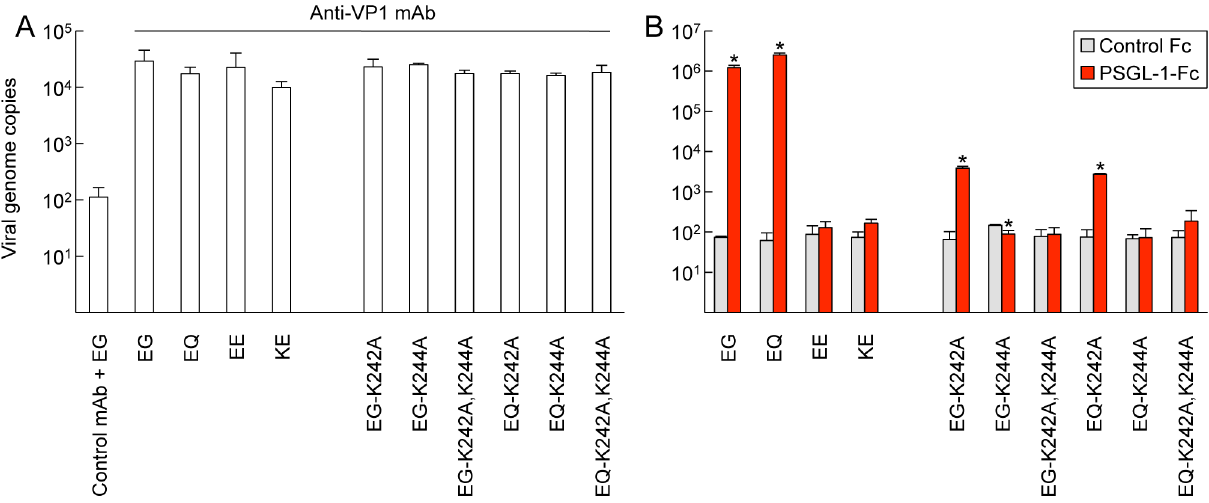
Figure 5. EV71–PSGL-1 binding assay using real-time RT-PCR. Viruses (5 6 10 7 viral genomes) were incubated with anti-VP1 mAb or PSGL-1-Fc and collected with protein G beads. Precipitated viruses were analyzed by real-time RT-PCR as described in Materials and Methods. Viral genome copies are expressed as the mean, and error bars indicate s. d. of three independent experiments. (A) Viruses were precipitated with anti-VP1 mAb to show the presence of virion in the sample. The amount of virus precipitated with nonspecific isotype control was considered as background binding (left). (B) Viruses were precipitated with PSGL-1-Fc. A control Fc chimeric protein (CTLA-4-Fc) was used as a negative control. Asterisks indicate a significant difference in specific binding to PSGL-1-Fc ( P , 0.01). Although there was a significant difference in EG-K244A, we consider it biologically meaningless.